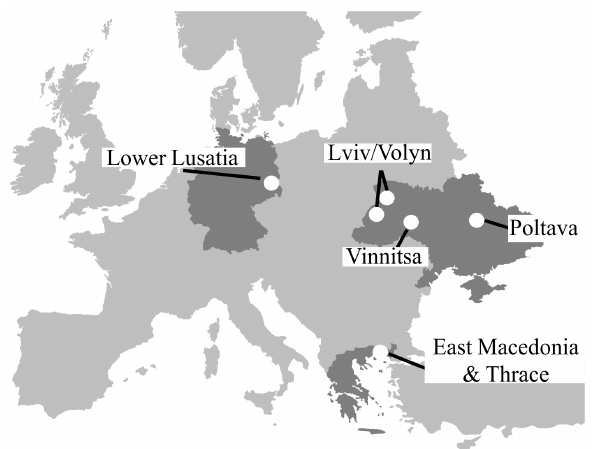
Figure 1. European regions with investigated case study